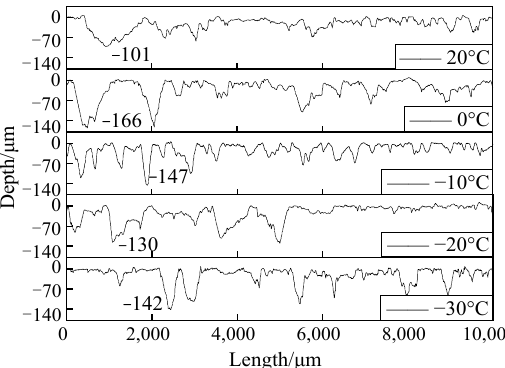
Figure 18. Surface profile of the brake pad braking material.